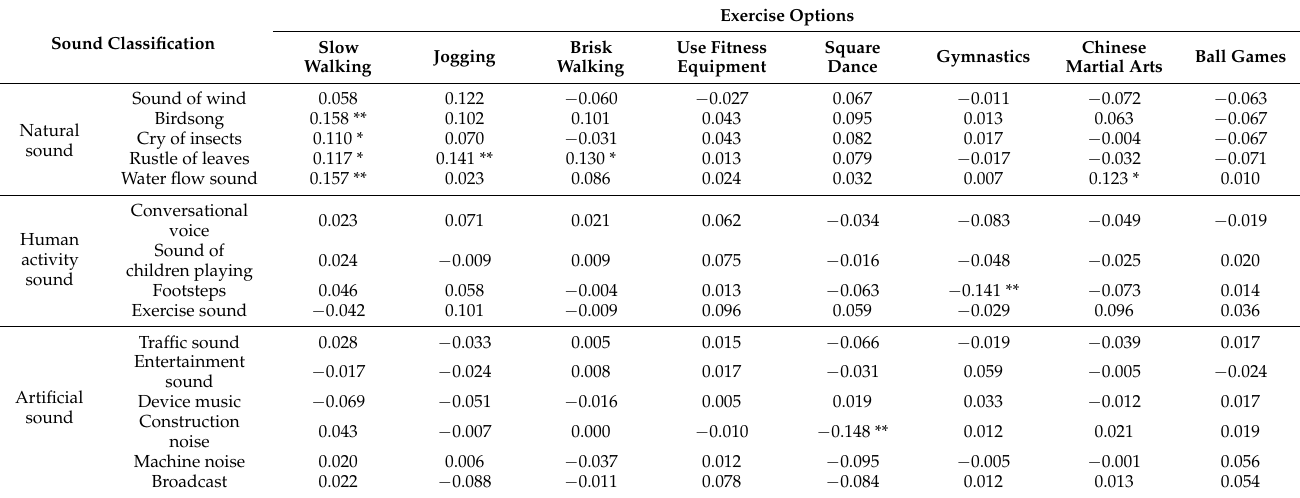
Table 2. Correlation between different exercise forms and soundscape preferences.